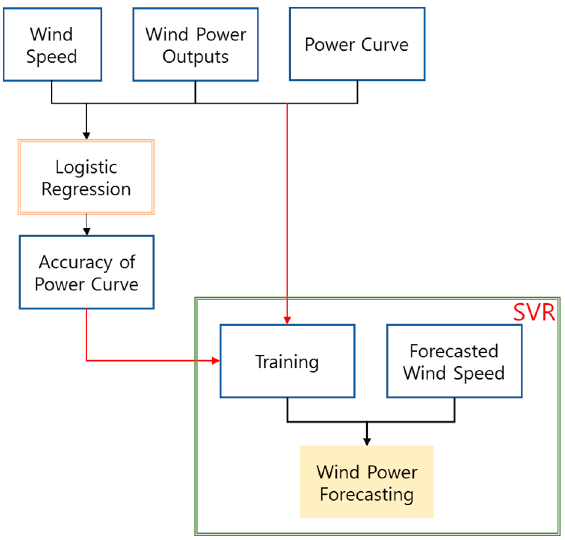
Figure 4. The process of wind power forecasting using logistic regression and SVR (support vector regression) method.